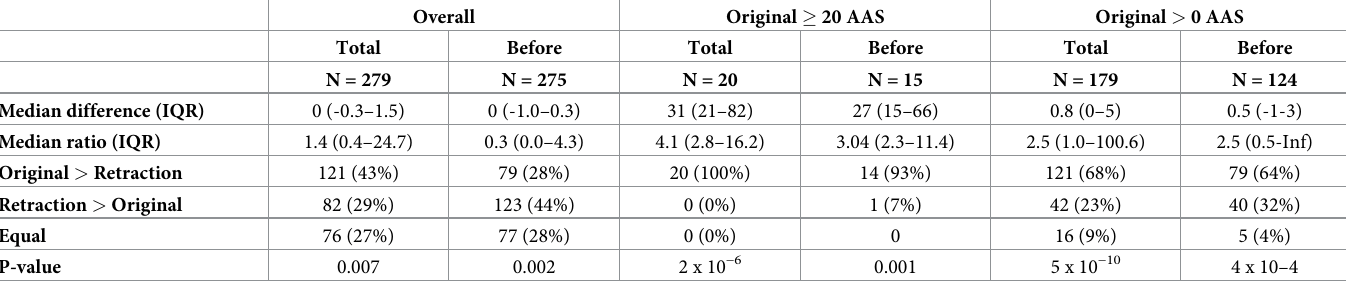
Table 2. Pairwise comparison of original article vs. retraction notice with and without post-retraction